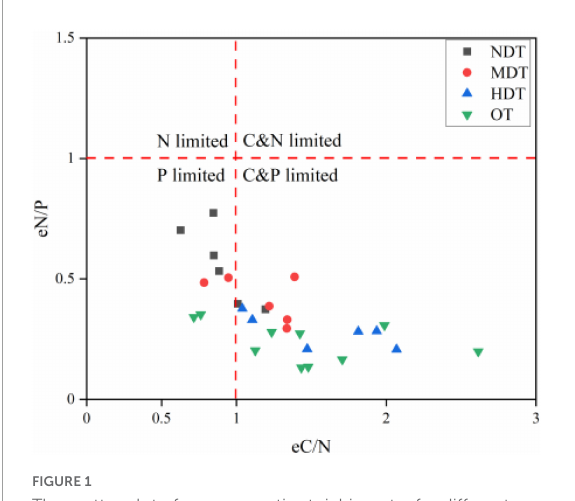
FIGURE1 The scatter plot of ecoenzymatic stoichiometry for different types of karst tiankeng. NDT, non-degraded tiankeng; MDT, moderately degraded tiankeng; HDT, heavily degraded tiankeng; OT, outside